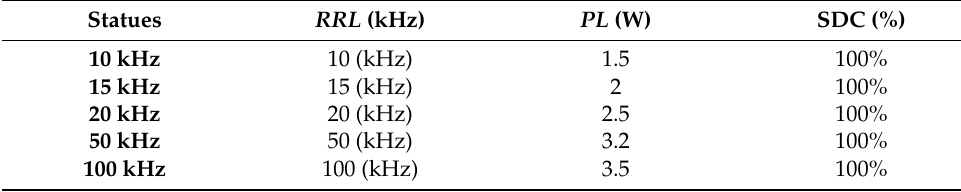
Table 1. RRL (kHz), PL (W) and SDC (%) for the five points of the “Part 1” experiments.